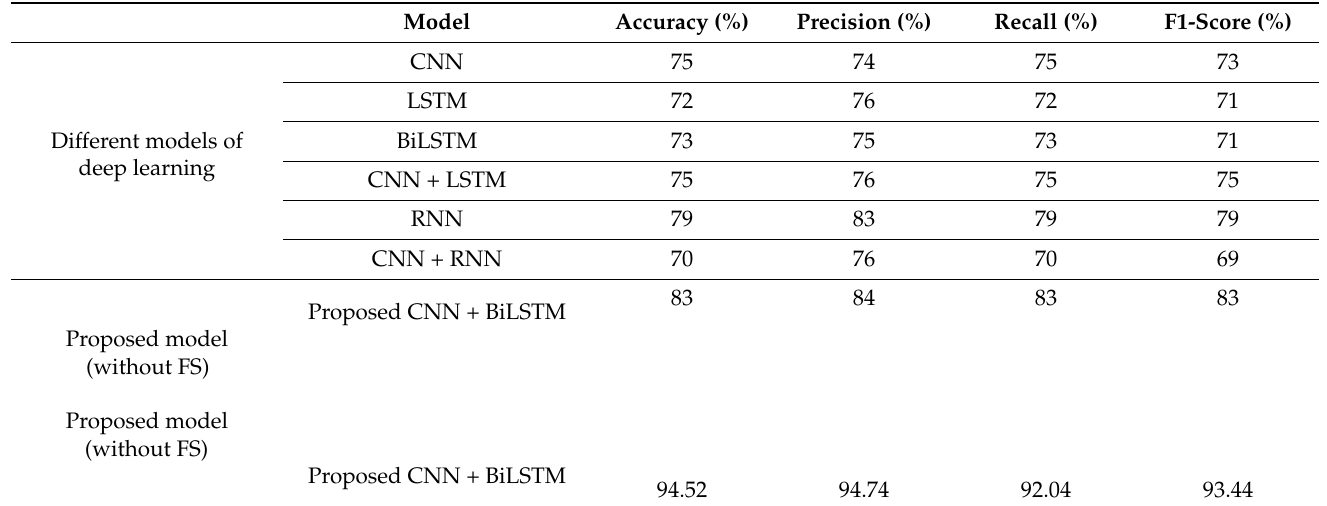
Table 9. Comparison of the proposed effectiveness of the algorithm to that of DL